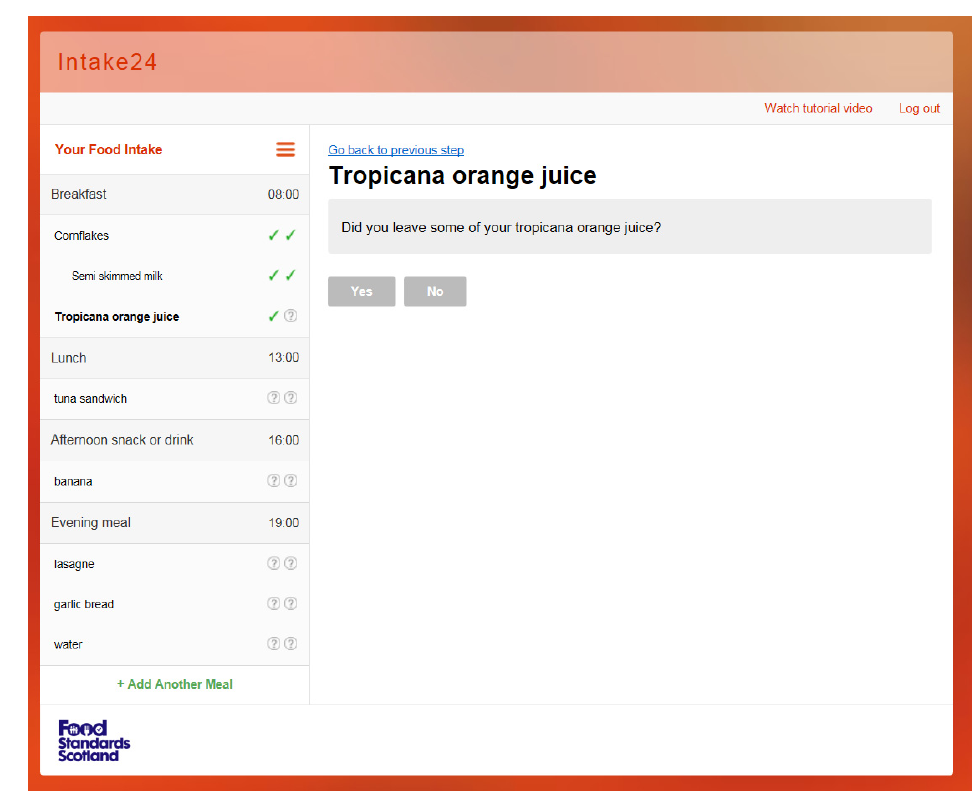
Figure 1. INTAKE24, contextual prompt in prompt panel. Food and drink items input shown on navigation panel.